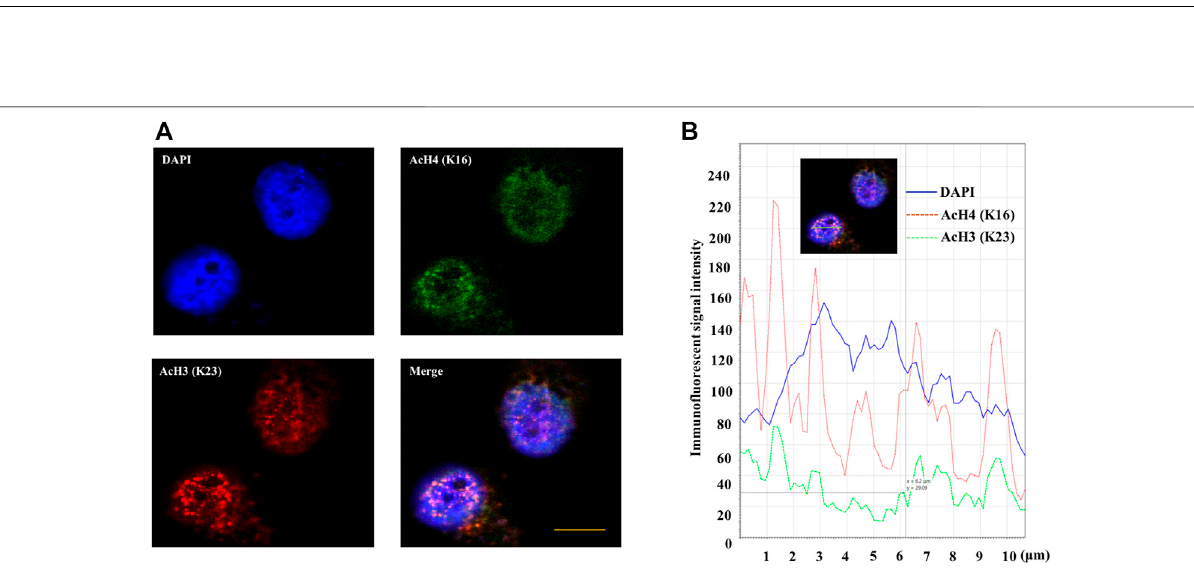
Frontiers in Molecular Biosciences |